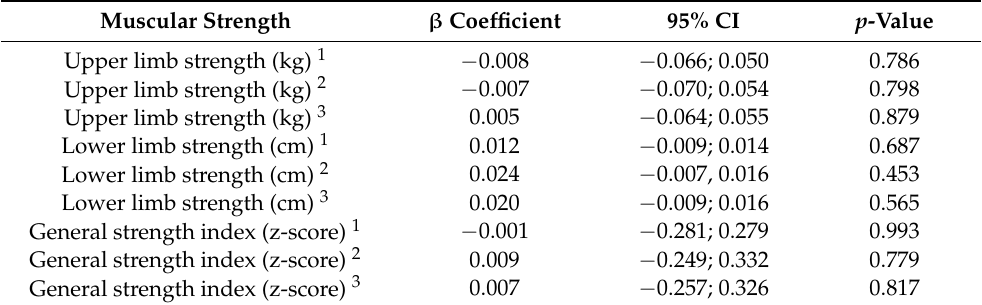
Table 2. Adjusted analyses between the muscular strength of upper and lower limbs and self-esteem in 9-year old Chilean schoolchildren: independent associations with body composition indicators. Muscular Strength β